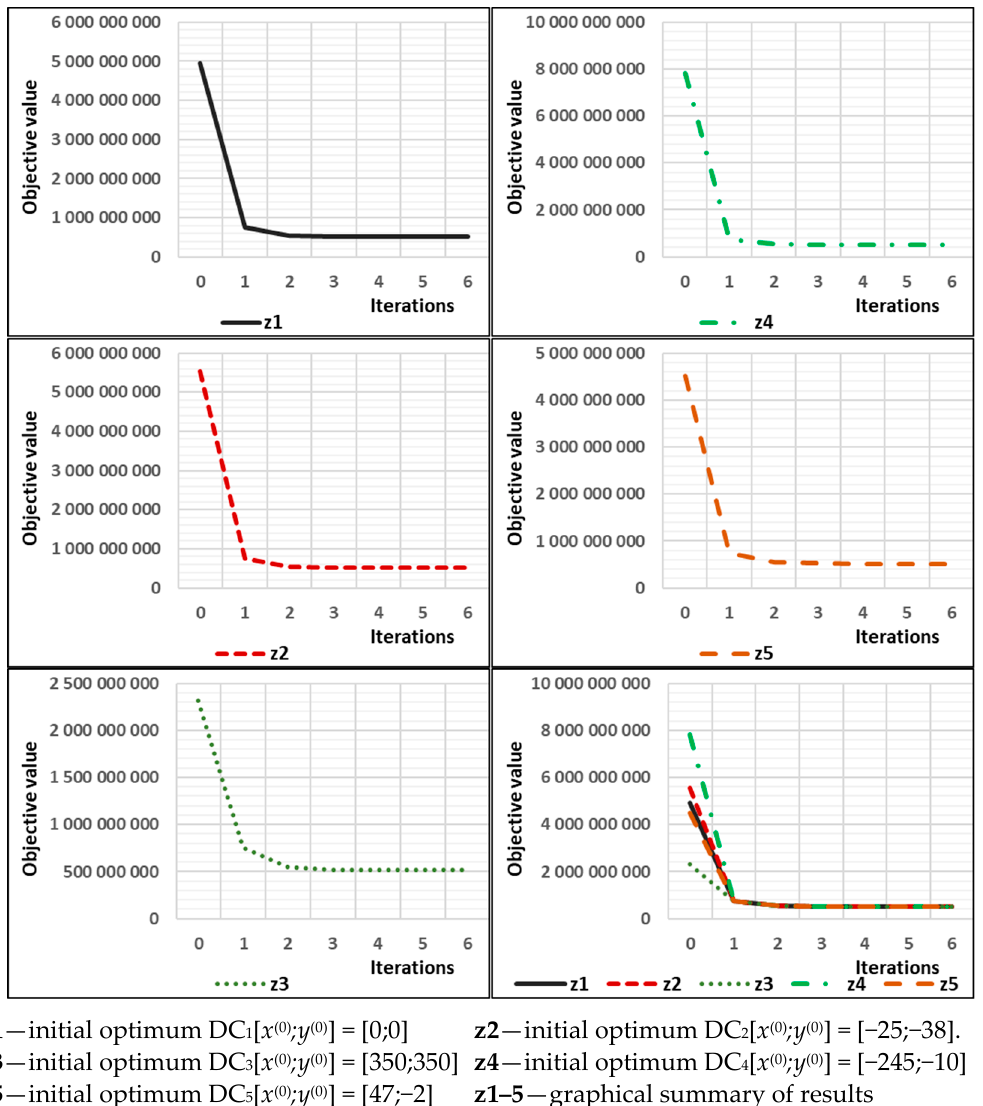
Figure 17. Graphical display of results of the objective function values calculating iterations from five different starting points.